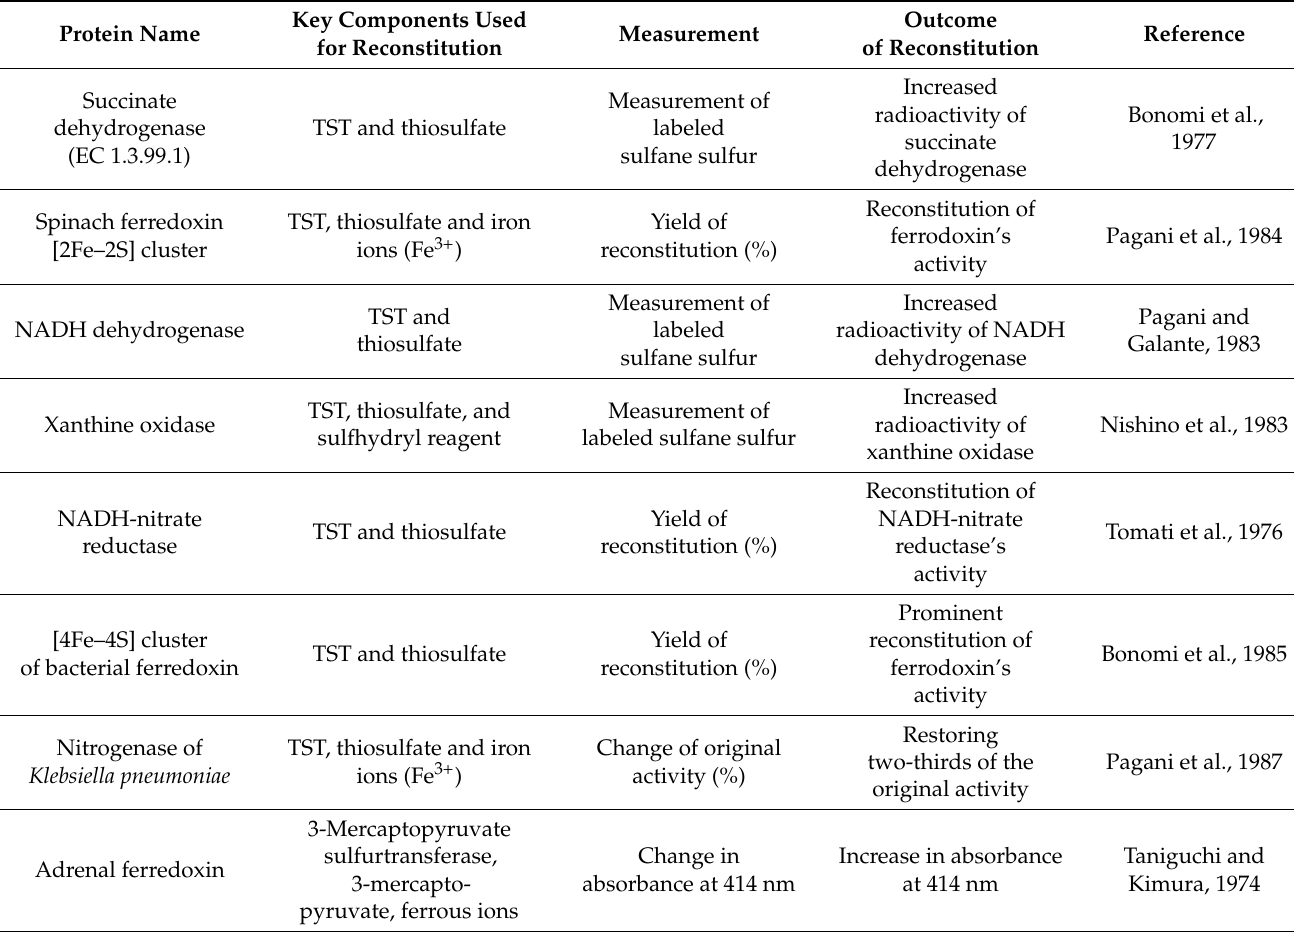
Table 1. List of enzymes that undergo a process of reconstitution of their activity with the participation of TST and